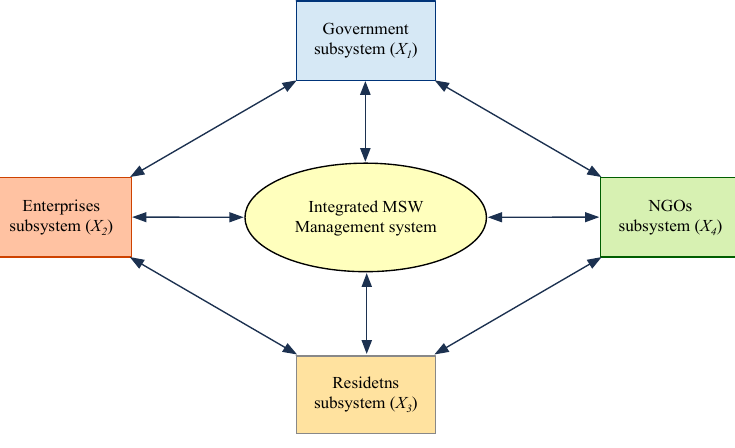
Figure 8. Integrated MSW management system.